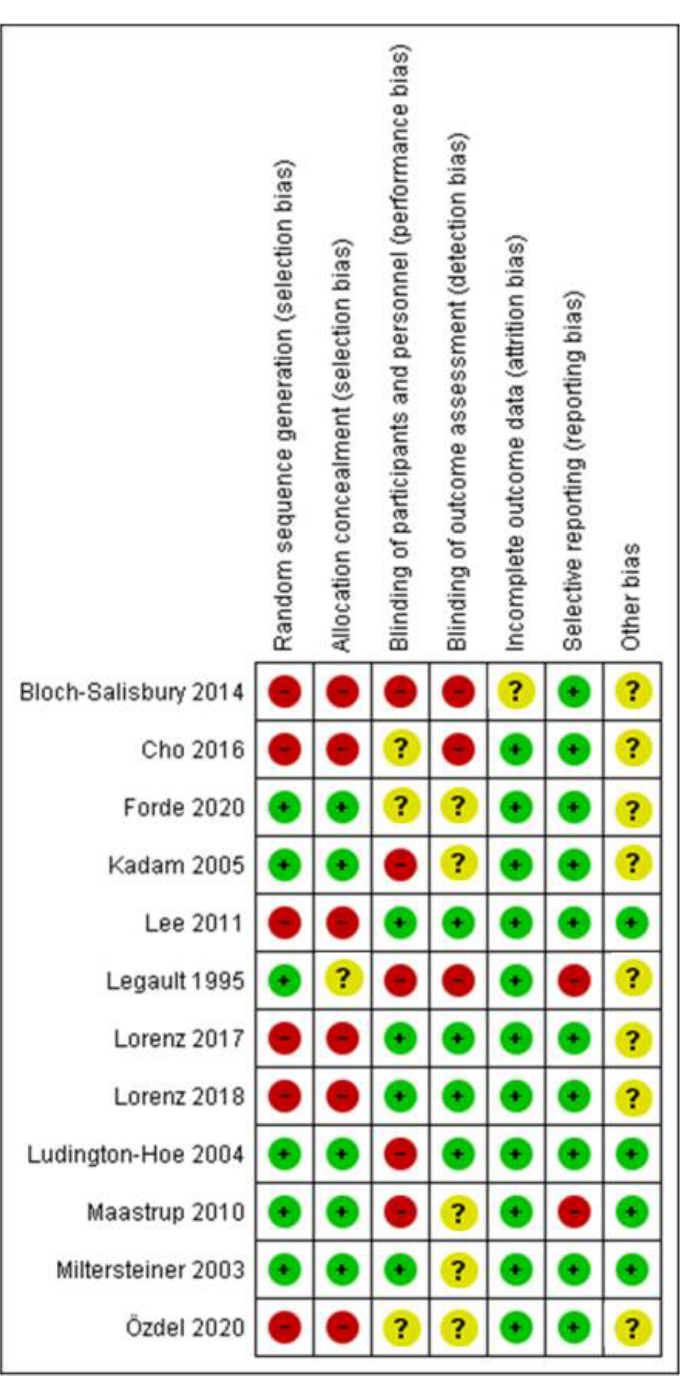
Figure 2. Summary of the risks of bias of the included studies.